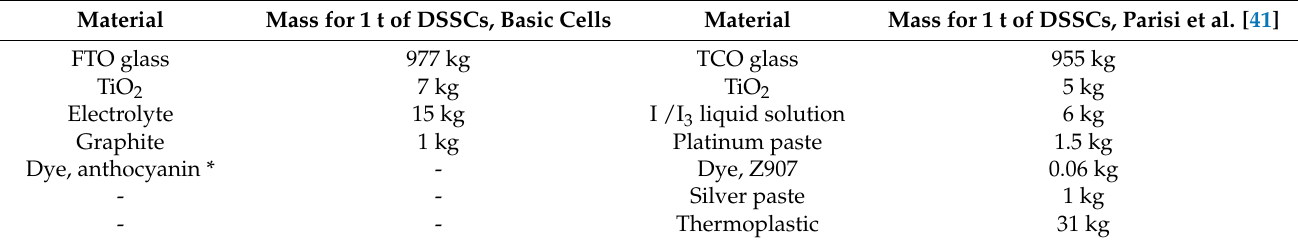
Table 7. Material composition of one ton of